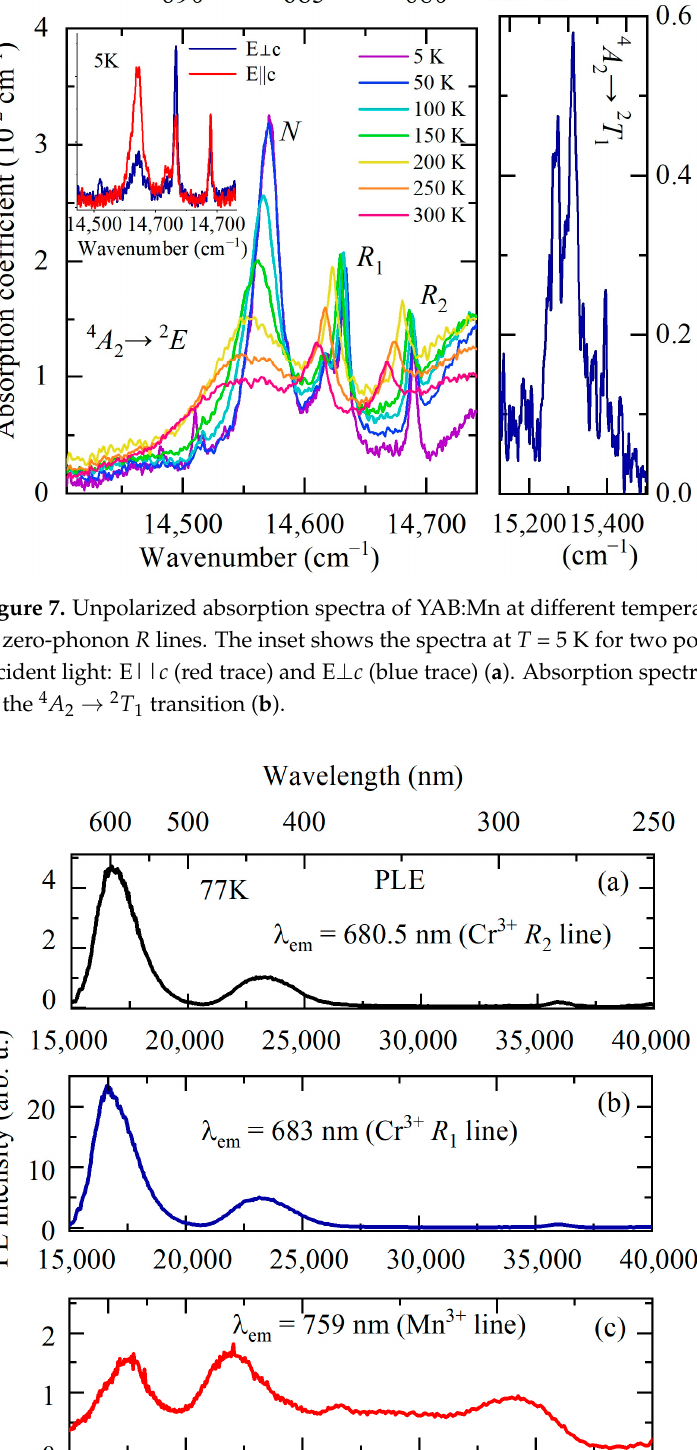
Figure 8. PL excitation spectra for YAB:Mn at T = 77 K monitored at 680.5 ( a ), 683 ( b ), and 759 ( c ) nm. A broad line at the low-frequency side of the R 1 and R 2 lines of the uncontrolled Cr 3+ impurity (denoted “ N ” in Figure 7a) noticeably narrows with decreasing temperature and, at low temperatures ( T < 100 K), it exceeds in amplitude the R 1 and R 2 lines. At the temperature T = 5 K, its frequency is 14,571 cm − 1 . The N line apparently refers to a tran- sition in exchange-coupled Cr 3+ -containing pairs. A very similar pattern was observed, for example, in the luminescence spectra of isostructural GdAl 3 (BO 3 ) 4 crystals doped with 1% Cr 3+ (GAB:Cr 3+ ) [17]. The authors attribute the corresponding transition to the emis- sion from the 2 E state of the Cr 3+ -Cr 3+ pairs. In our case, the formation of Cr-Mn pairs could also be possible. The inset of Figure 7a shows the absorption spectra at the lowest measured temper- ature ( T = 5 K) for two directions of incident light polarization, E|| c and E ⊥ c . The ratio of the amplitudes of the R 1 and R 2 lines is in agreement with the corresponding ratio for YAB:Cr 3+ [38] (namely, I( R 1 )/I( R 2 ) = 1 for E|| c , I( R 1 )/I( R 2 ) = 2 for E ⊥ c ), which once again confirms the origin of the observed R lines as stemming from the uncontrolled Cr 3+ im- purity. It is also worth noting that we found the same R lines of approximately the same intensity in “pure” YAB crystals grown from the same chemicals in the same laboratory as the YAB:Mn crystals under study. The rest of the spectrum observed for YAB:Mn is absent in YAB, so it is obviously associated with manganese.